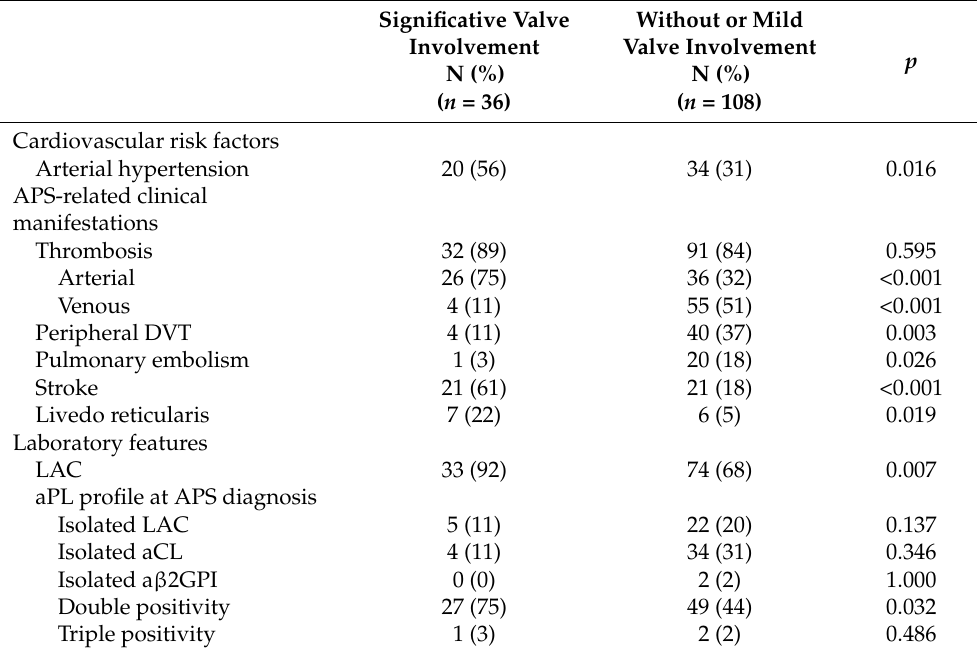
Table 4. Comparison between group with moderate and severe valve involvement versus group without valve involvement and/or with mild involvement or valve thickening without functional